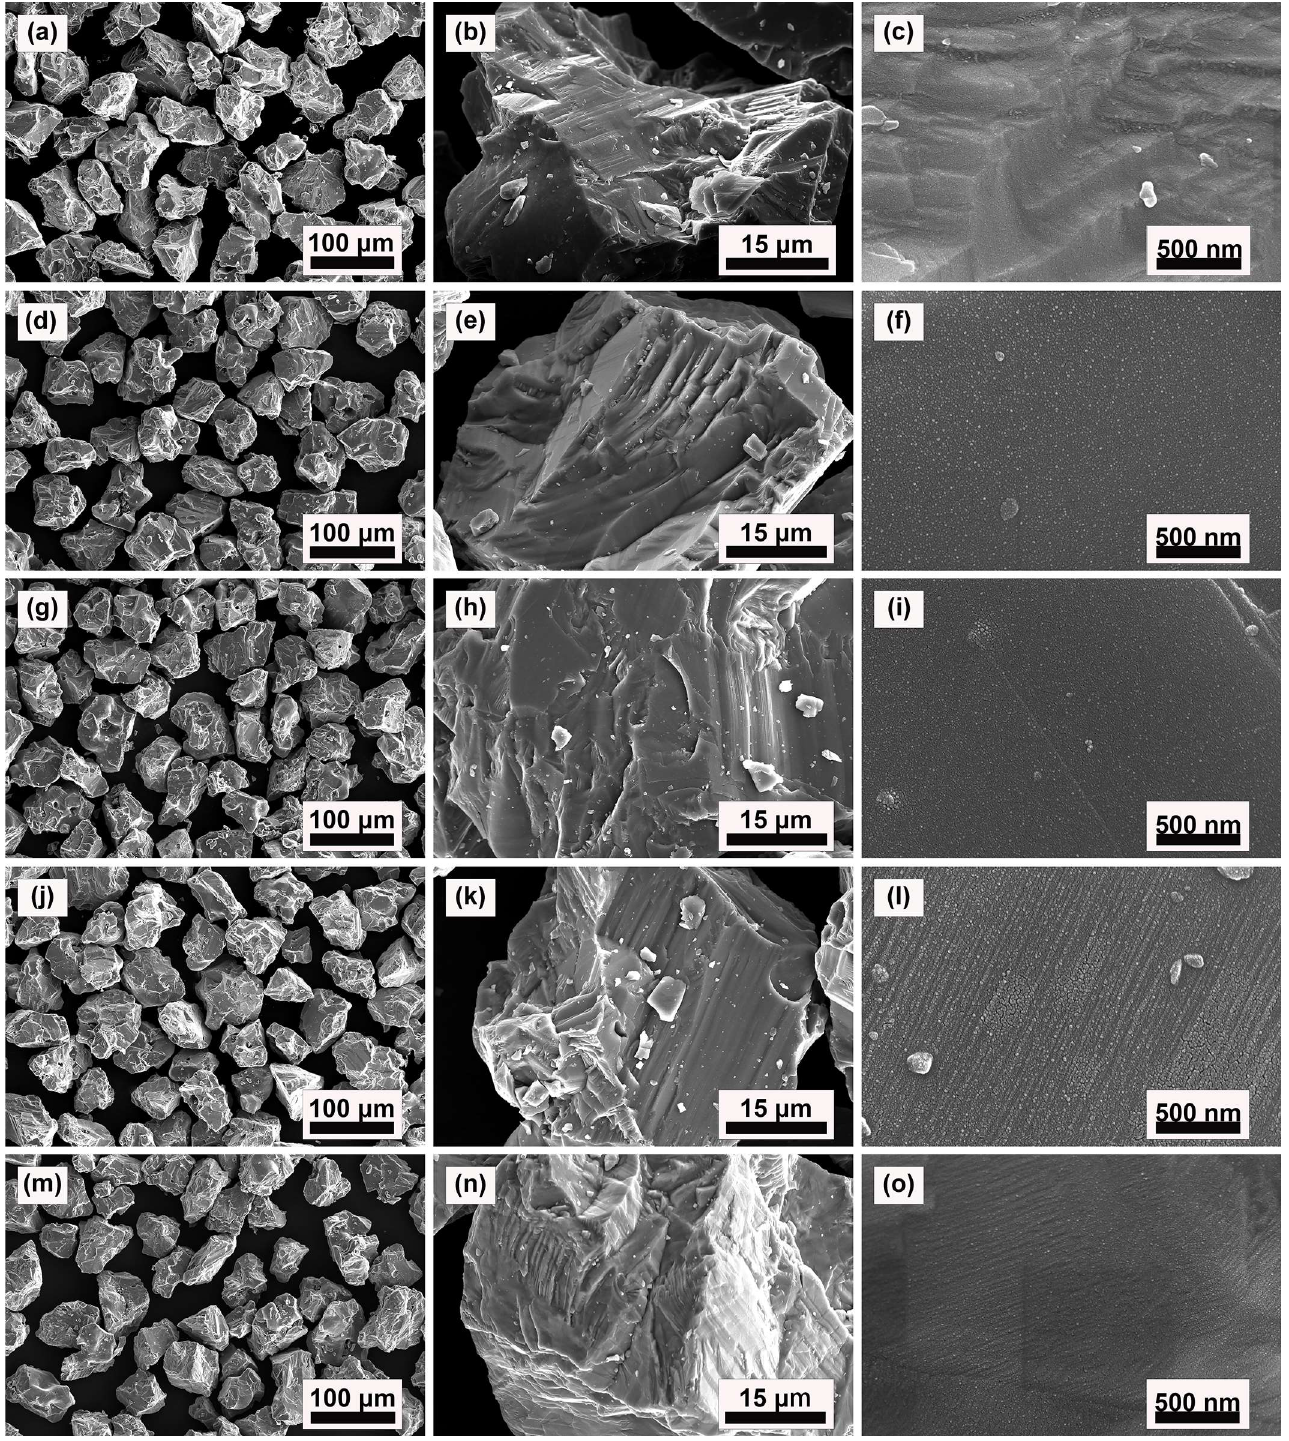
Figure 1. SEM images of the TiH 2 ( a – c ), the Dehy-1 ( d – f ), Dehy-2 ( g – i ), Dehy-3 ( j – l ), and HDH Ti ( m – o ) powders.